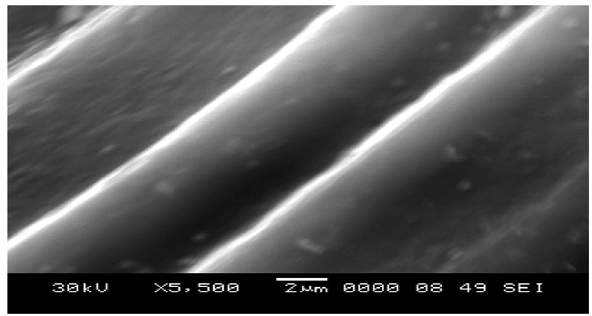
Fig. 2 SEM images of Posidonia oceanica fibers